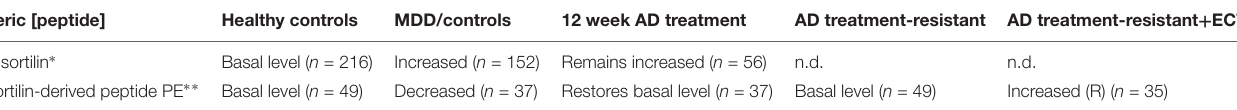
TABLE 1 | Seric concentration of s-sortilin and sortilin-derived peptide in healthy controls, MDD before and after AD treatment or ECT. Seric [peptide] Healthy controls MDD/controls 12 week AD